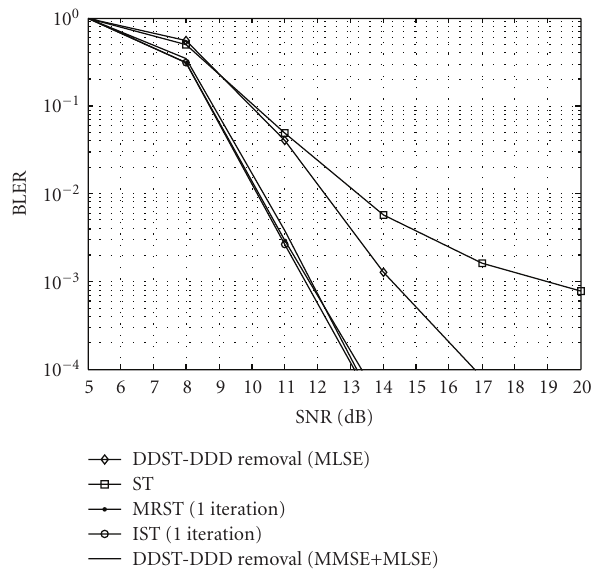
Figure 6: BLER performance of BPSK signals with MLSE equalizer using the three iterative methods and